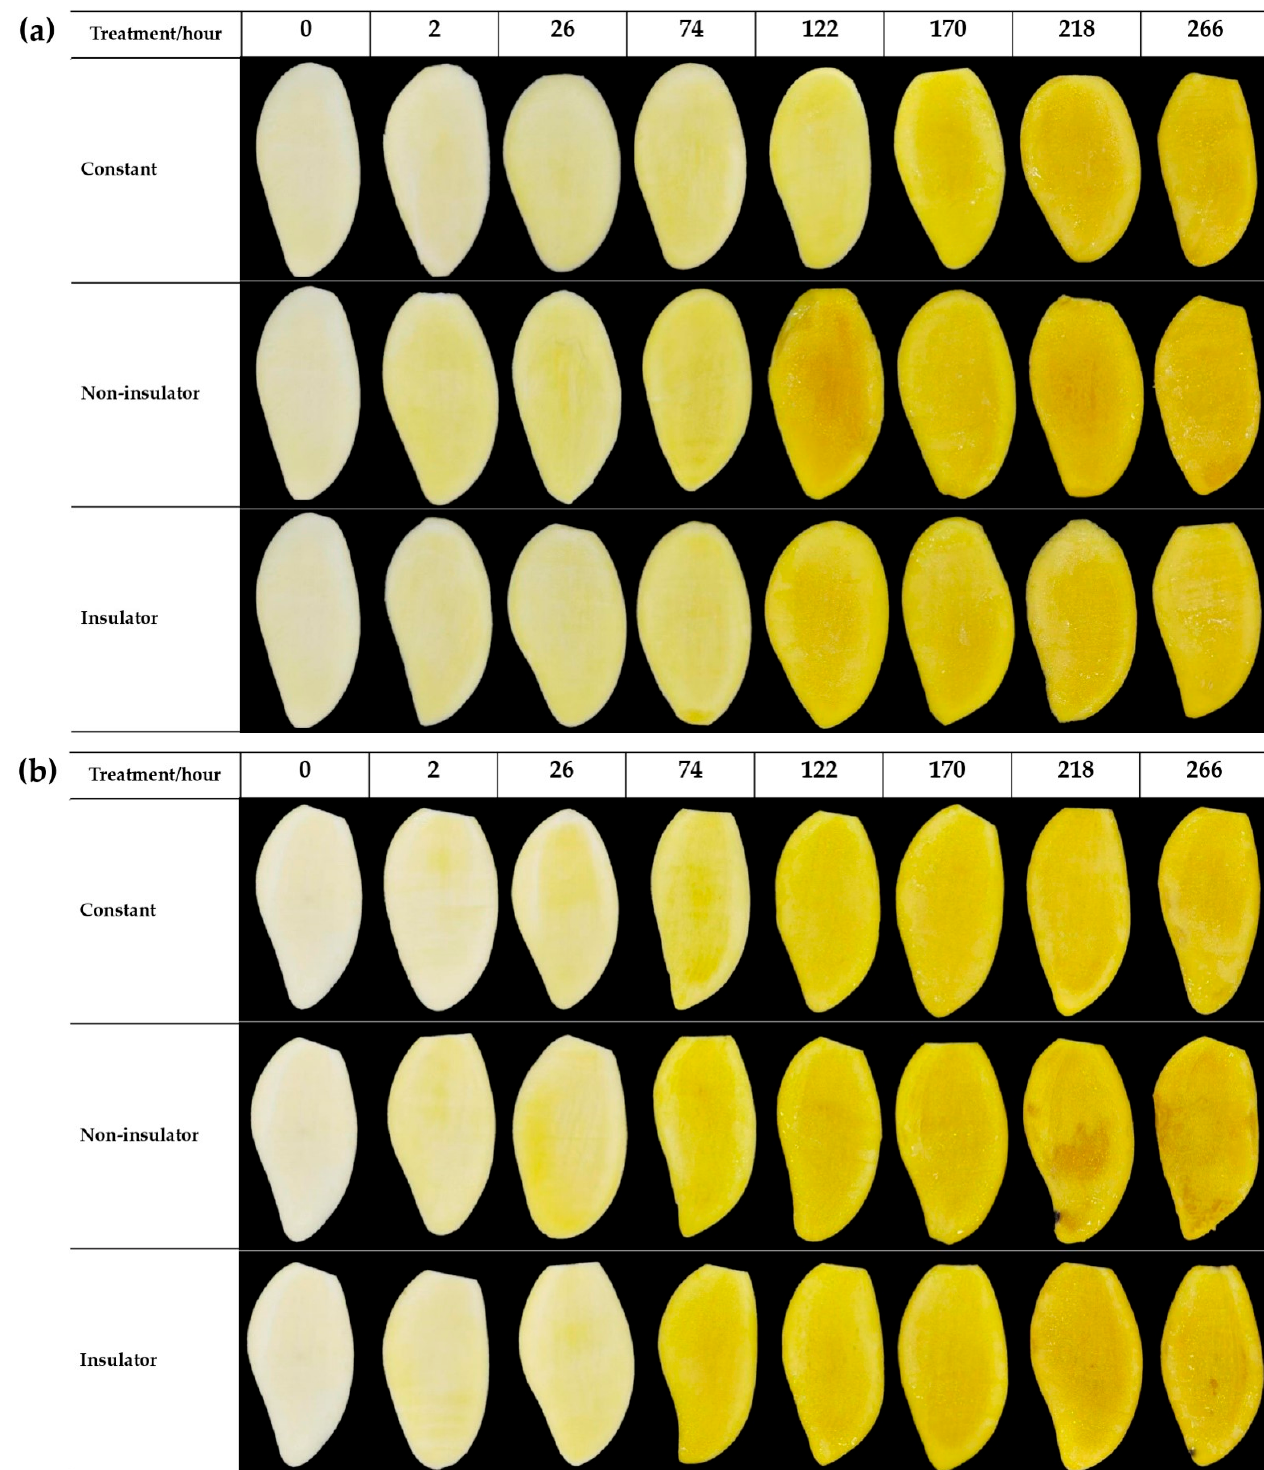
Figure 8. Colour of the flesh near the seed of mango fruits (‘Nam Dok Mai Si Thong’) from the ( a ) first harvest and ( b ) second harvest under constant, non-insulated, and insulated conditions during simulated handling at the tarmac. After simulated handling at the tarmac, mango fruits were transferred to 20 °C for 266 h.